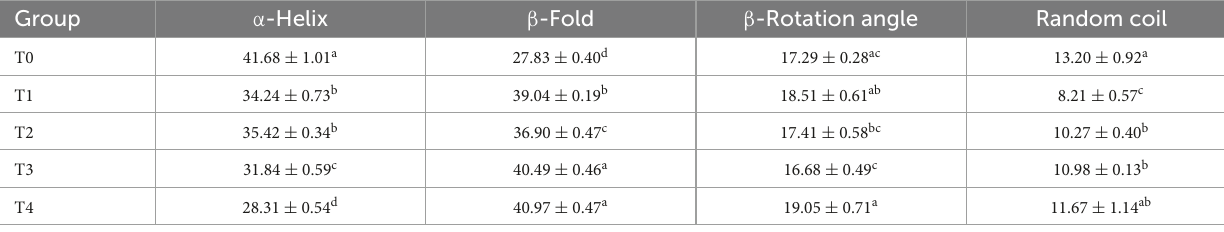
T0: control group; T1: 6.06% chaff dietary fiber; T2: 6.06% soybean hull dietary fiber; T3: 6.06% inulin; T4: 1.40% chaff dietary fiber +1.42% soybean hull dietary fiber +3.24% inulin; Different lettersinthesamecolumnindicatedsignificantdifferencesbetweenthesamples( P <